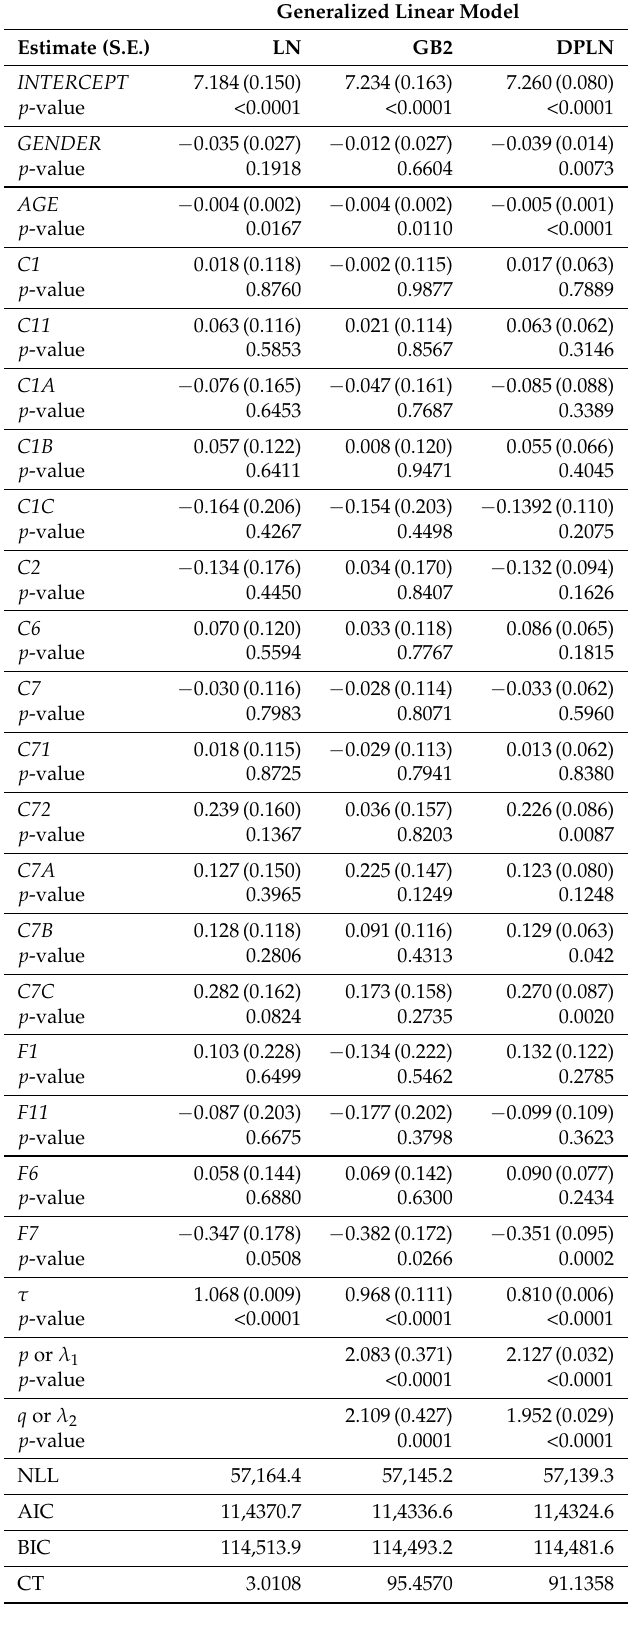
Table 1. Parameter estimates, standard errors (S.E.) and p -values of the t -test for automobile insurance claims dataset under lognormal distribution (LN), generalized beta distribution of the second kind (GB2) and double Pareto lognormal distribution (DPLN) generalized linear